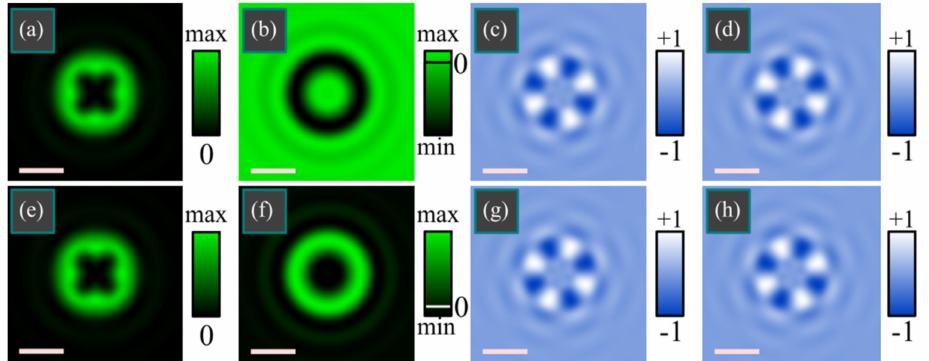
Figure 3. Distributions of intensity ( a , e ), radial component of the Poynting vector ( b , f ), normalized- to-maximum longitudinal component of the SAM vector ( c , g ), and normalized-to-maximum lon- gitudinal component of the OAM vector ( d , h ) of a sharply focused Gaussian beam with 3rd-order cylindrical polarization before the focus ( a – d ) and beyond the focus ( e – h ). In all the figures, light and black colors mean, respectively, maximum and minimum. Scale marks (in the bottom left corner) denote 1 µ